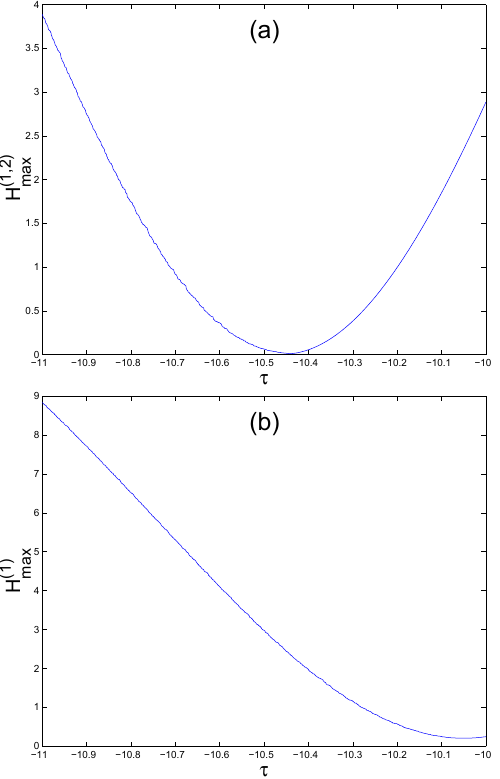
Figure 7. H ( 1 , 2 ) max (ρ ∗ ,τ) for (a) f 4 (x) and (b) f 5 (x) . H ( 1 , 2 ) mm is ∼ 0.0091 and ∼ 0 . 2068,